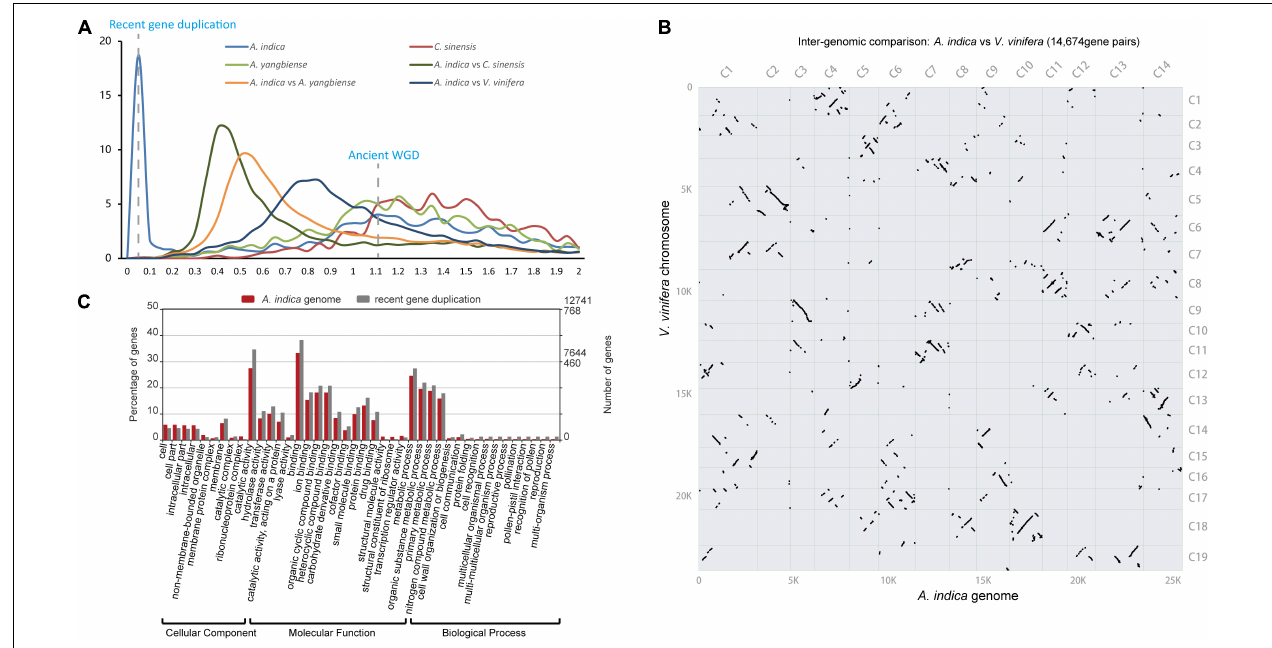
FIGURE 3 | Genome evolution of A. indica . (A) Ks distribution (The gene pairs located in syntenic blocks) between syntenic genes within the A. indica genome or between genomes. (B) Inter-genomic syntenic analysis between A. indica genome and V. vinifera genome. (C) GO enrichment of the A. indica genome (green) and genes retained after recent gene duplication (orange) ( P < 0.05). *Pearson chi-square test P -value < 0.05; **Pearson chi-square test P -value <